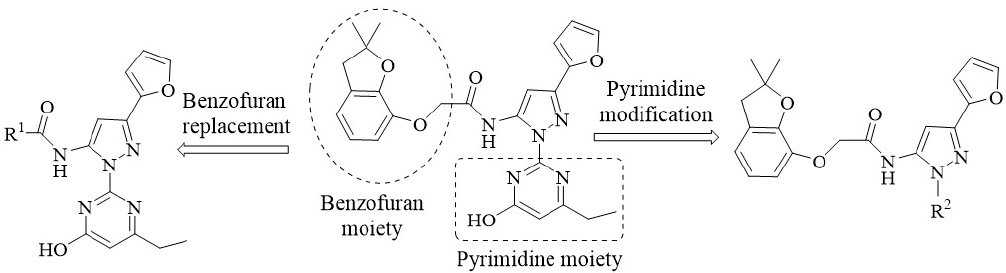
Scheme 1. The design strategy for new compounds.